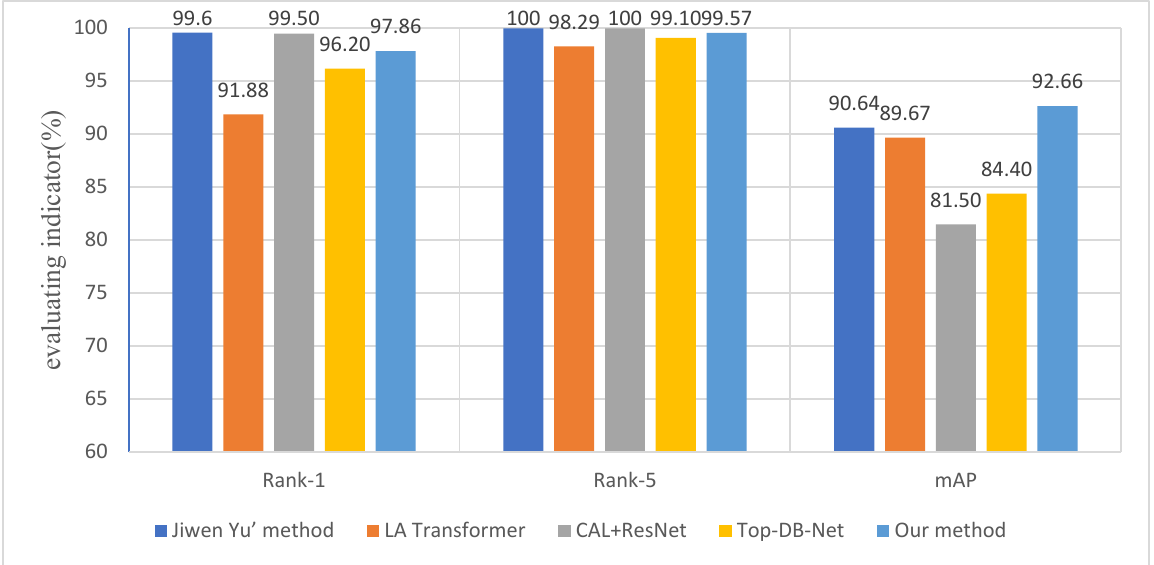
Figure 7. Experimental comparison results between the model with cross-attention and other models.